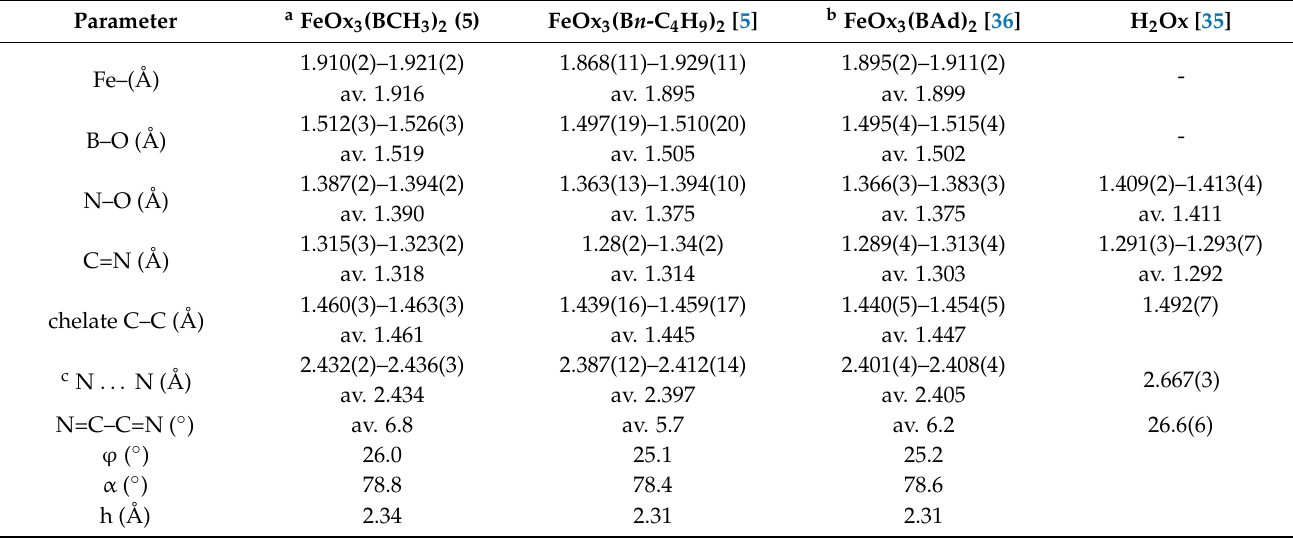
Table 2. Main geometrical parameters of the alkylboron-capped iron(II) tris-octoximate molecules and those for initial α -dioxime (octoxime).